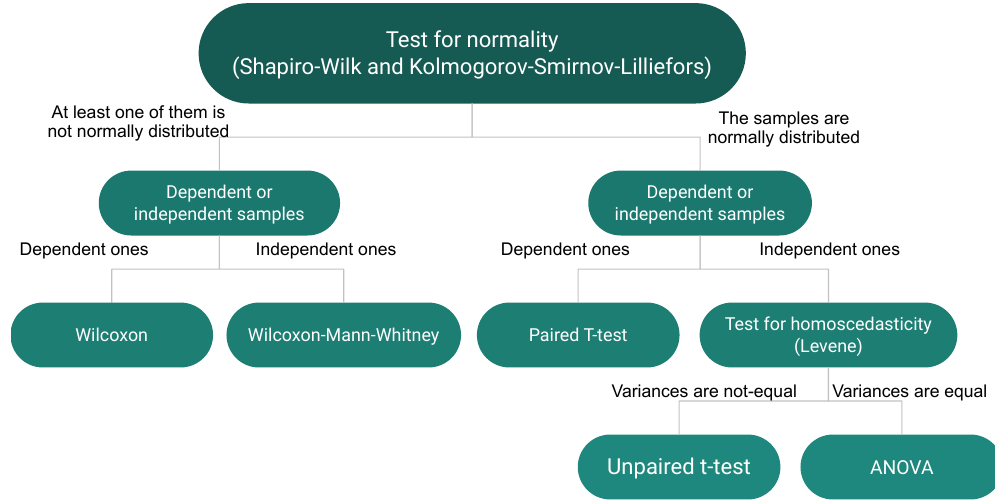
Figure 3. Statistical significance test.